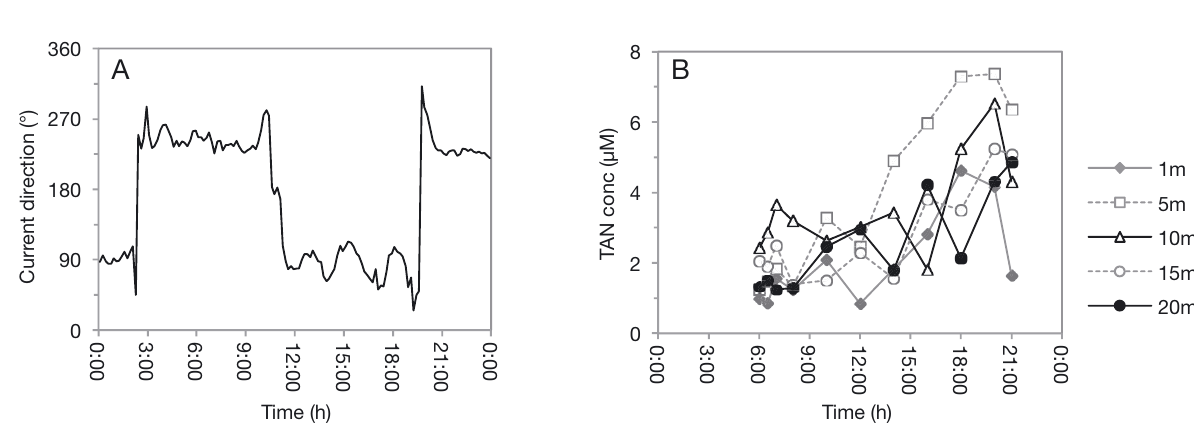
Fig. 9. Within-day variability in (A) current direction measured at 5 m depth and (B) average ammonium concentrations meas- ured directly beside a salmon net pen at the 5 sampling depth intervals in September 2013. Ammonium sampling was per- formed during daylight